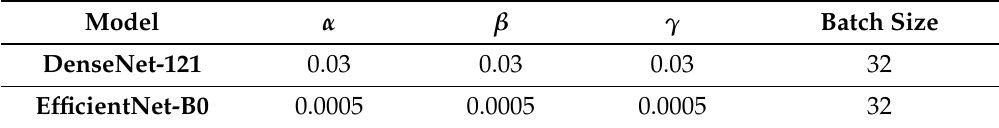
Table 4. Training settings of